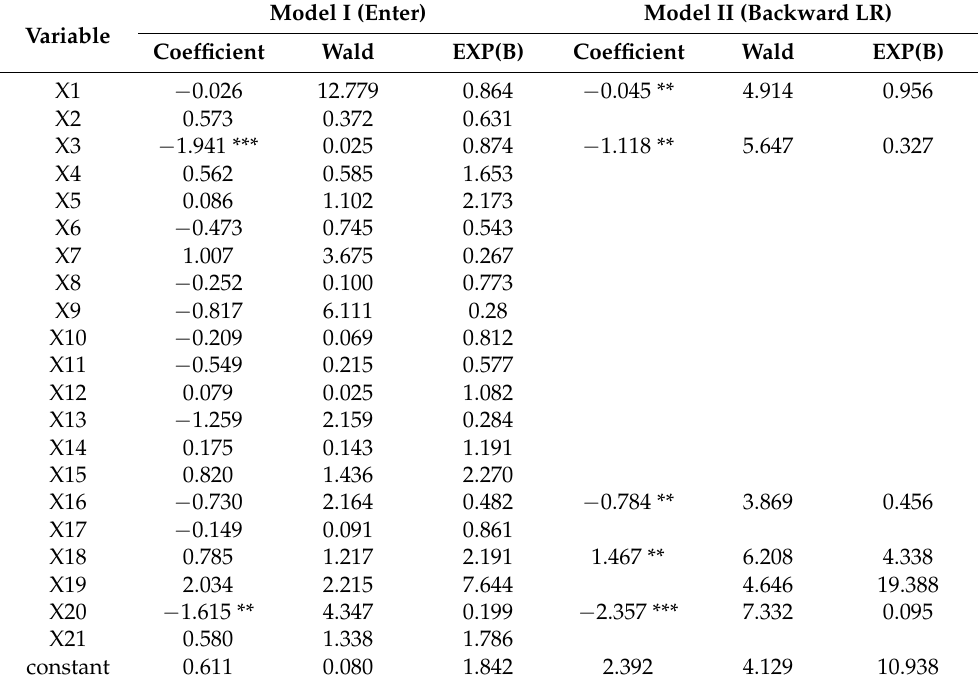
Table 5. Regression results of the logistic